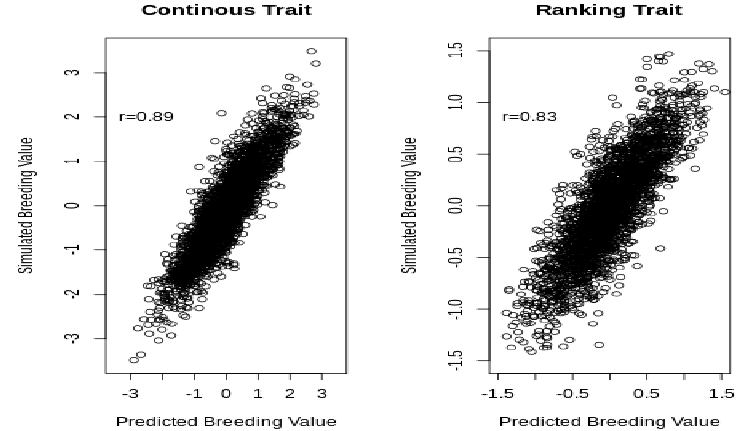
Figure 3. Two-dimensional plots of the simulated and predicted breeding values for the continuous and the liability of the ranking